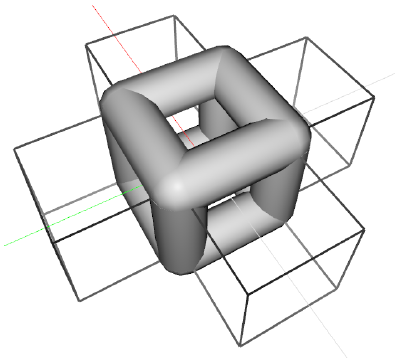
Figure 7. Thickened cubic cell entering neighbour cells.